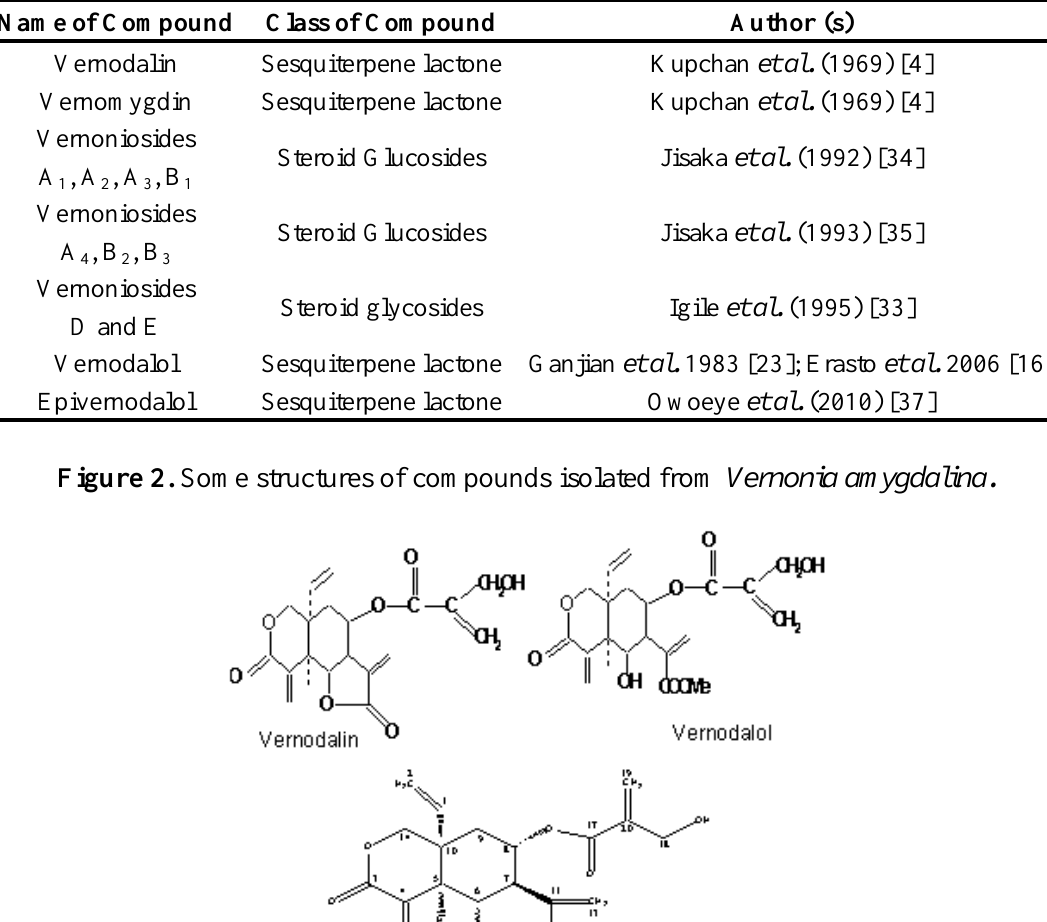
Table 1. Bioactive compounds isolated from Vernonia amygdalina.